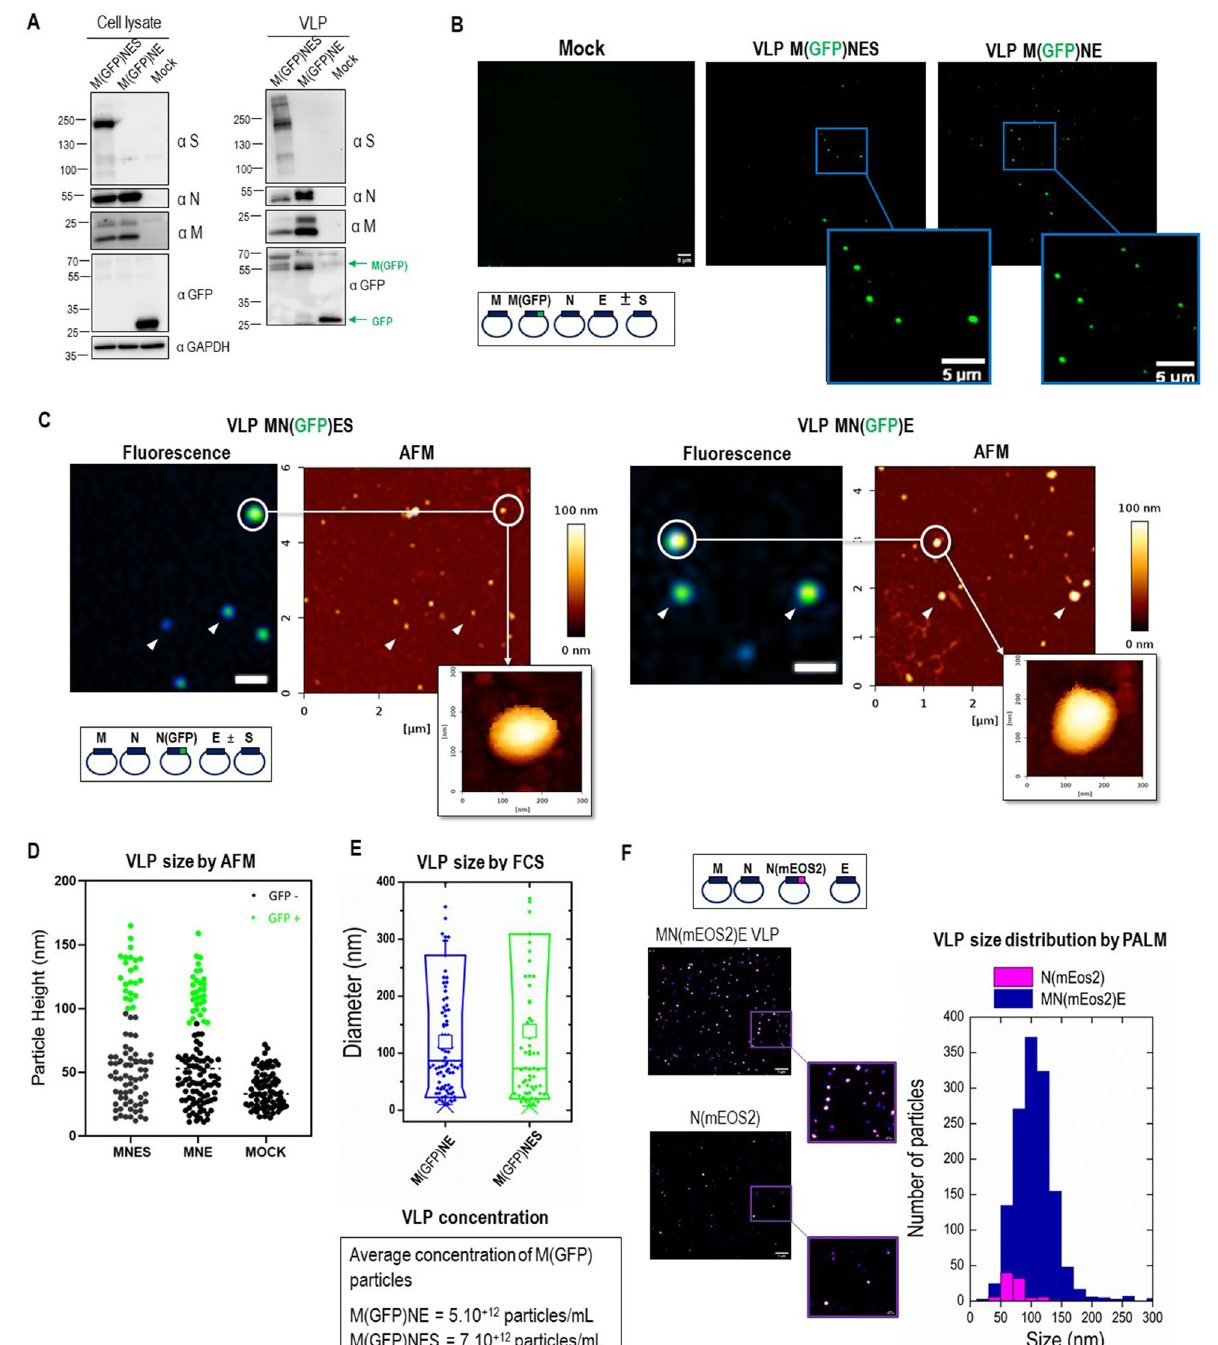
Figure 2. Size and concentration of fluorescent and photoconvertible SARS-CoV-2 VLPs. ( A ) Western blot of cell lysates and VLPs of HEK293T cells transfected with M/M(GFP), N, E ± S with the optimal plasmid ratio of M/M(GFP):N:E ± S as 2/2:12:2 ± 5. ( B ) TIRF microscopy images of SARS-CoV-2M(GFP)NE and M(GFP) NES VLPs were deposited on a glass coverslip. The scale bar is 5 µm. ( C ) Correlative AFM and wide-field fluorescence images of fluorescent SARS-CoV-2 MN(GFP)E and MN(GFP)ES VLPs. Scale bars represent 1 µm. ( D ) AFM Size (particle height) distribution of all particles adsorbed on the surface in the MN(GFP)ES and MN(GFP)E VLPs preparations versus the mock control (extracellular vesicles naturally released from the transfected cells). The number of particles counted were 86, 81 and 84 respectively. The GFP+ particles found by correlative AFM are indicated as green dots. ( E ) The size and concentration of M(GFP)NE and M(GFP) NES VLPs are determined by FCS. ( F ) Images and quantitative size distribution of MN(mEOS2)E VLPs and N(mEOS2) particles using super-resolution PALM microscopy. All these experiments were done twice with more than several hundred of particles analyzed in each